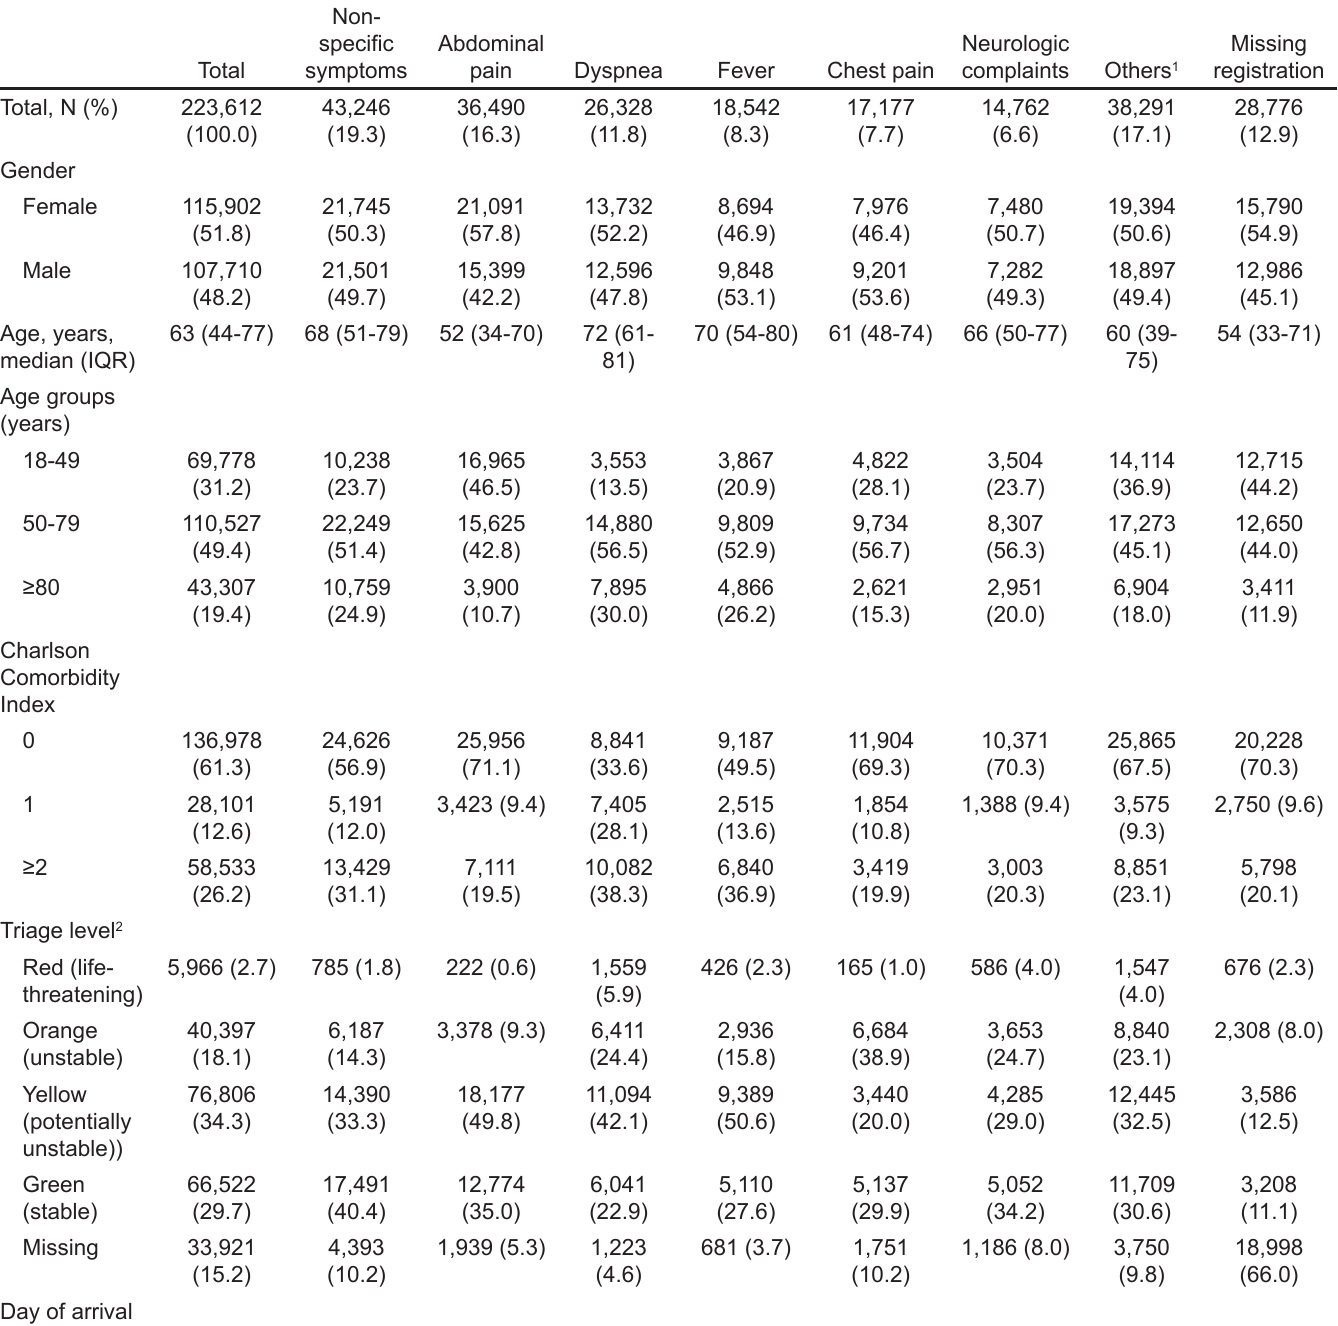
Table 1. Characteristics of the adult non-trauma emergency department patients arriving at a hospital in the Region of Southern Denmark between